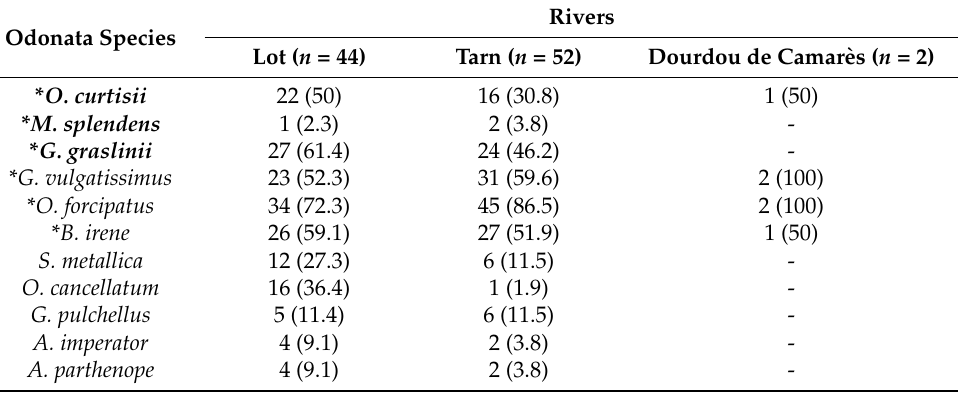
Table 2. List of dragonflies species with more than 10 exuviae detected on each river (Lot, Tarn, and Dourdou de Camar è s) with the total number of transects where the species was detected at least once and the associated percentage of positive transects (between parentheses). Riverine species according to Dijkstra [10] and Boudot and Grand [33] are indicated by asterisks and this study’s target species (i.e., protected ones) are indicated in bold.